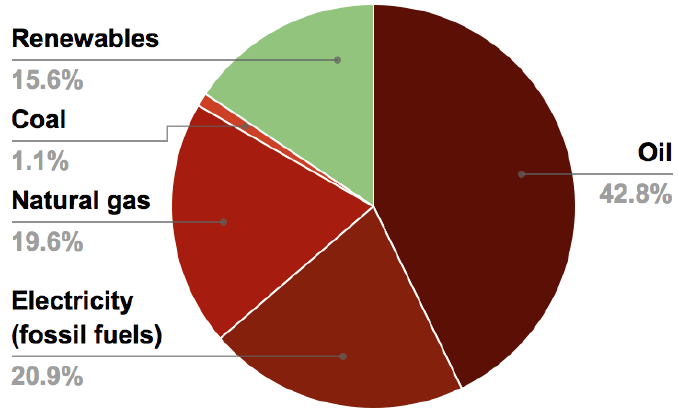
Figure 2. Global energy subsidies, 2012. Long-entrenched policies blindly favor fossil fuels [14].